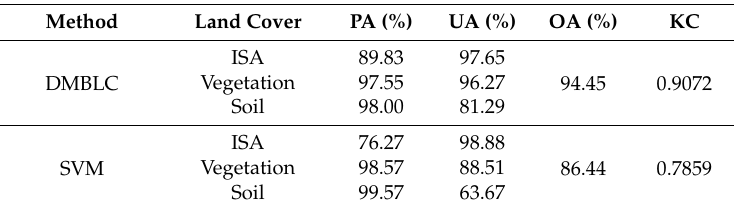
Table 3. Accuracy comparison between the DMBLC and SVM methods for classification of ISA, vegetation, and soil.